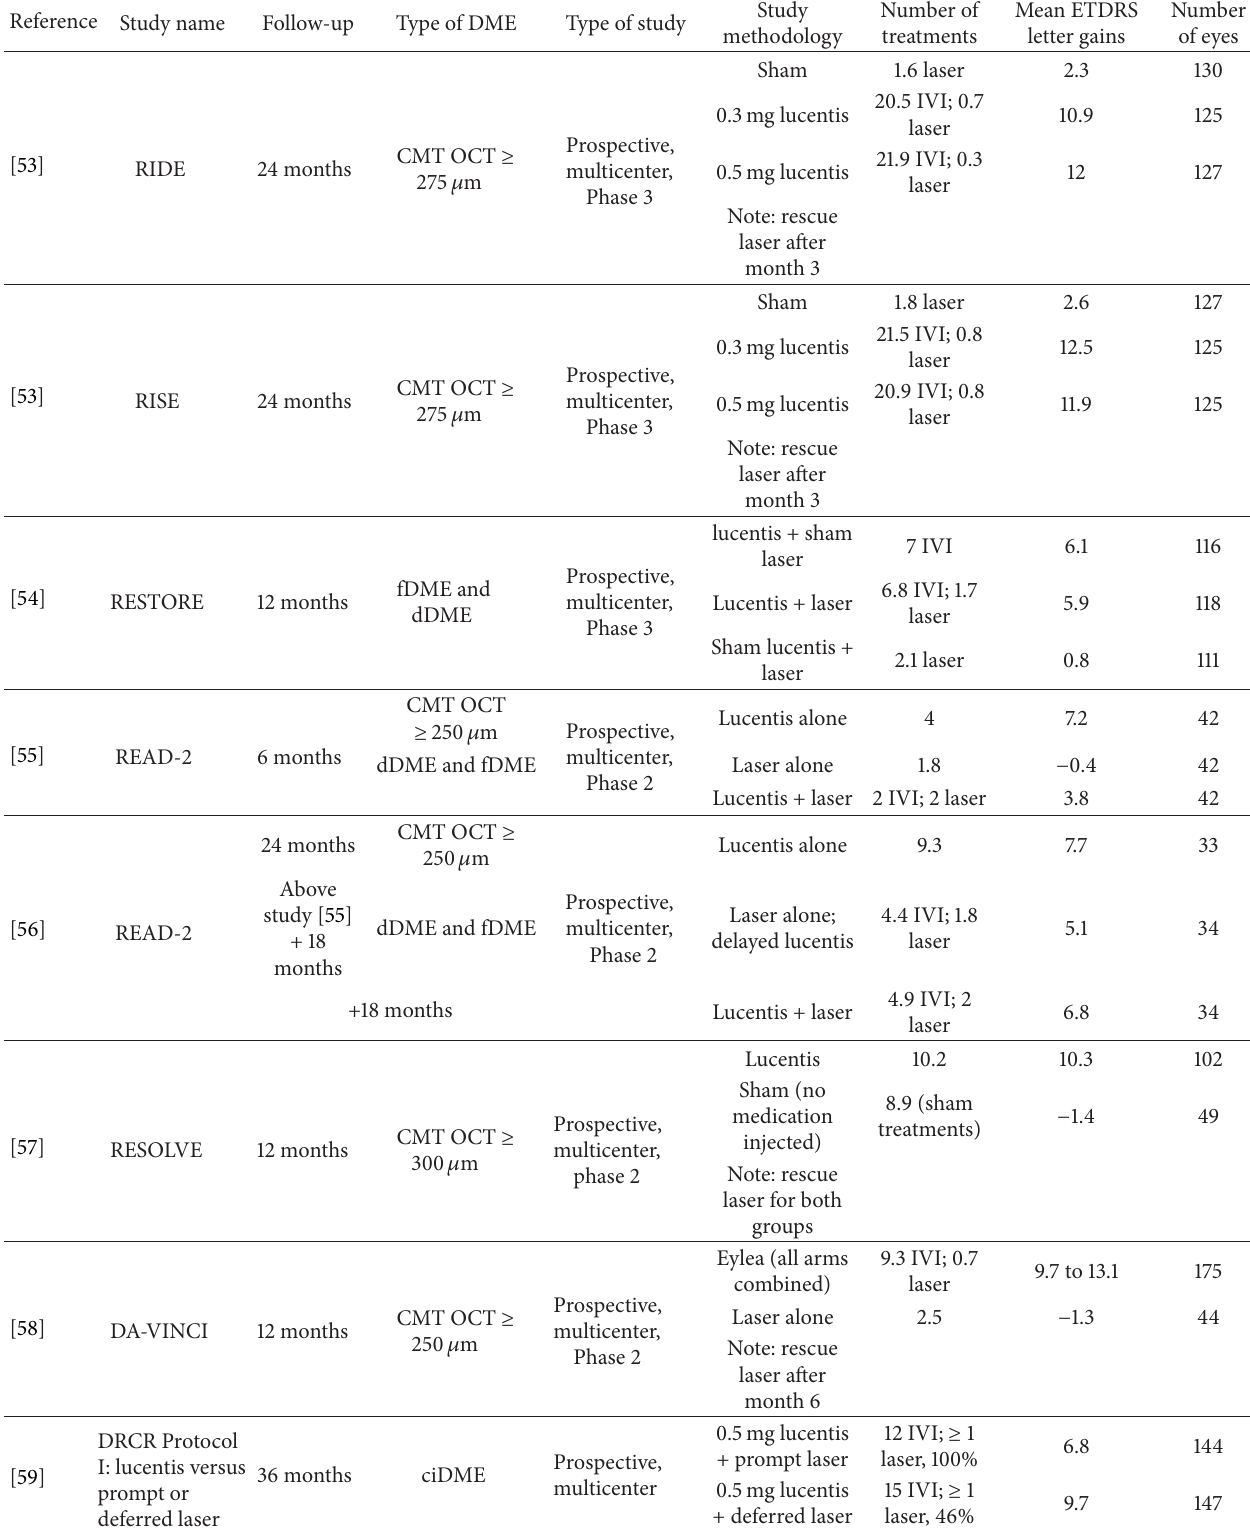
Table 3: Summary of major studies evaluating anti-VEGF medications for